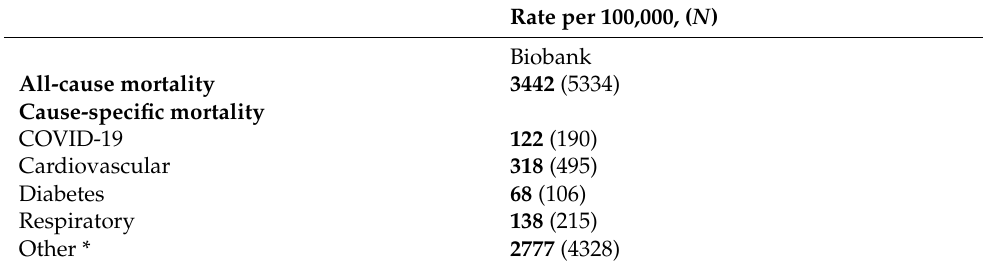
Table 2. Mortality rates. Mortality rates among 155,859 Biobank participants through January